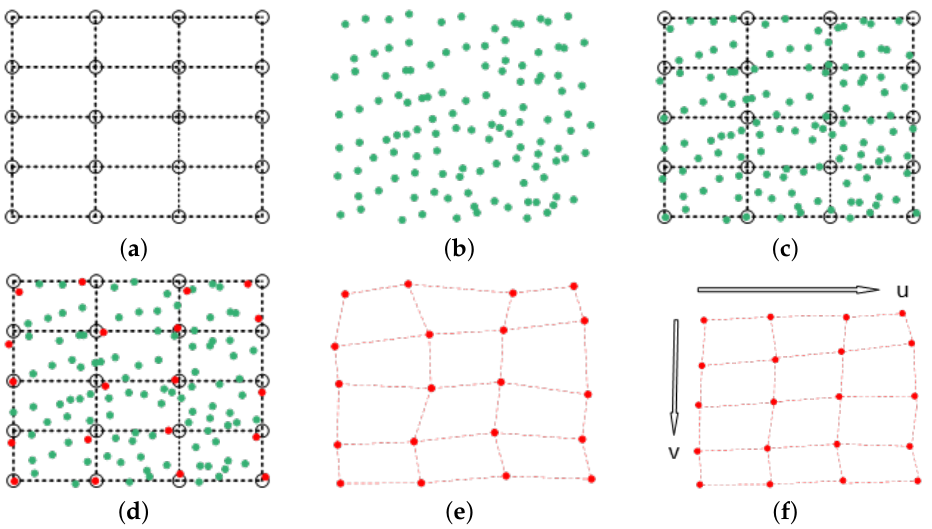
Figure 8. The process of grid point offset. ( a ) The grid point of CAD model. ( b ) The points of point cloud data. ( c ) Each grid point of the CAD grid is connected with the point cloud data through a unified coordinate system relationship. ( d ) Nearest neighbor of the CAD grid point in the point cloud model. ( e ) Grid point of the deformed workpiece. ( f ) A NURBS of real workpiece constructed by shape value grid